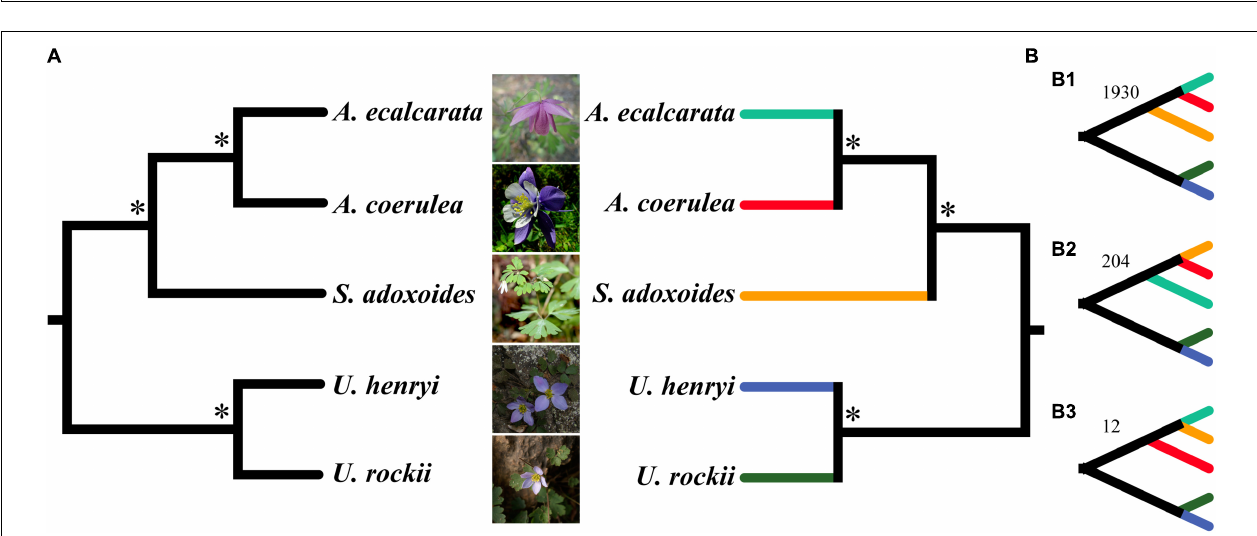
FIGURE 5 | Function annotation for the 30 clusters of paralogous genes under significant adaptive evolution. (A–E) indicate the detail information of U. rockii , U. henryi , S. adoxoides , A. ecalcarata and A. coerulea.